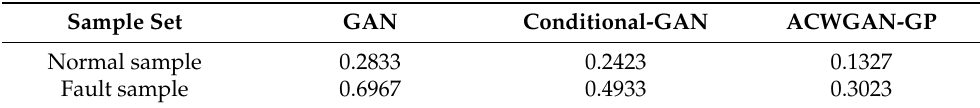
Table 8. Different model RMSE results comparison.